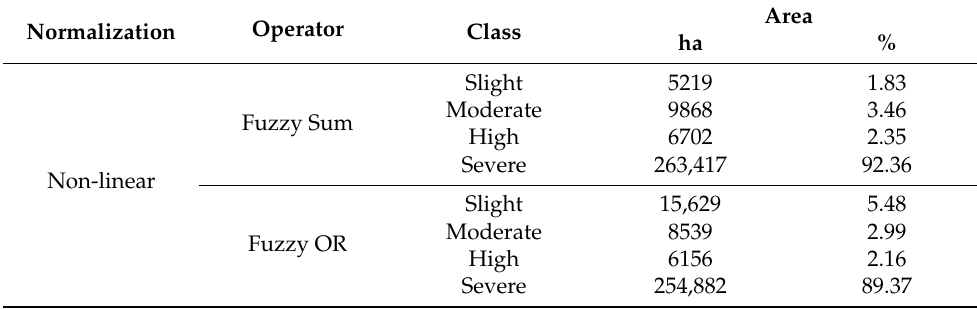
Table 5. Areas of soil pollution classes derived from the most suitable